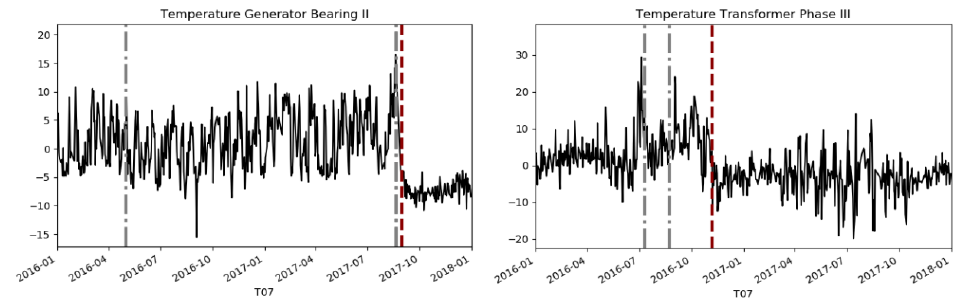
Figure 9. Results of the KCPD algorithm for the generator bearing ( left ) and the transformer ( right ) with processed measurement over time (black), annotated malfunctions of the respective component (grey dashed), and detected change points (red